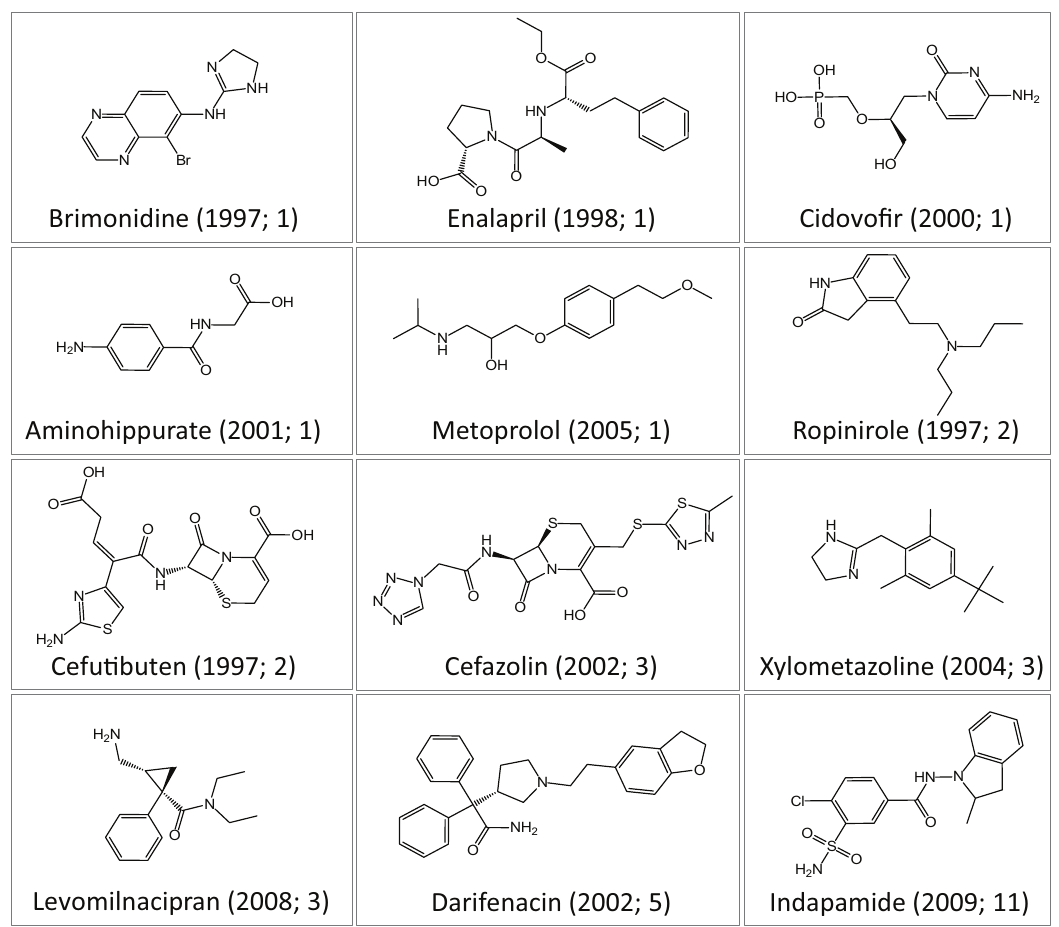
Figure 7. Drugs with constant promiscuity over time. Shown are 12 exemplary drugs having a constant promiscuity rate on the basis of high-confidence activity data. For each drug, the year of its first activity report and the number of targets it was active against are given. For example, brimonidine was first reported to be active against a single target in 1997.